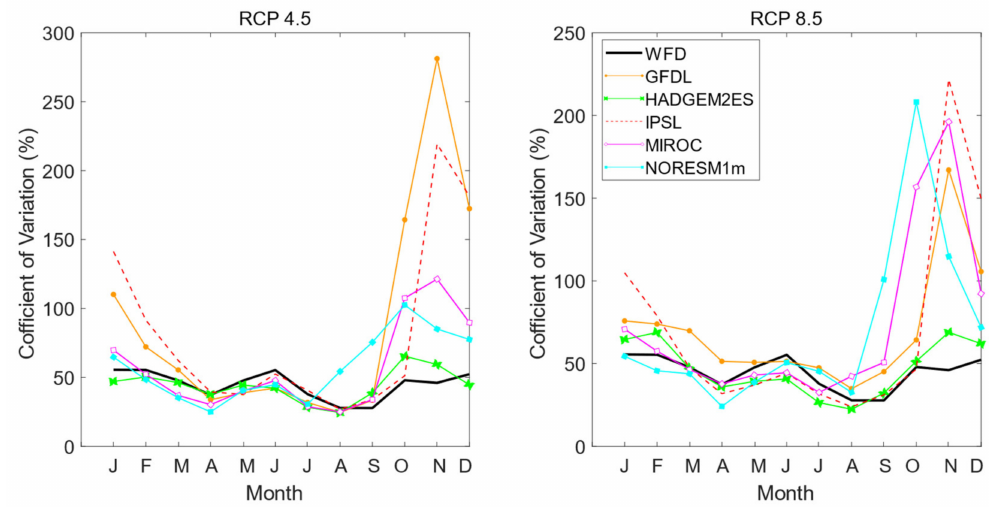
Figure 13. Monthly coefficient of variation in discharges for the WFD and GCM models and both scenarios.